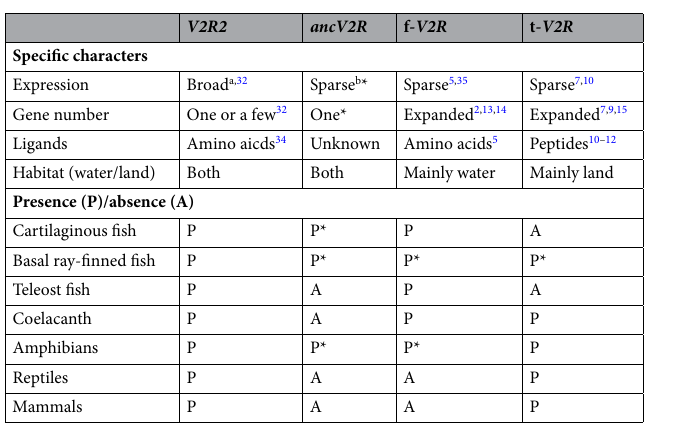
Table 2. Summary of current knowledge on four V2R clades. *Newly found in this study. a broadly expressed in all vomeronasal neurons and co-expressed with the other V2R s. b sparsely expressed according to one neuron one receptor